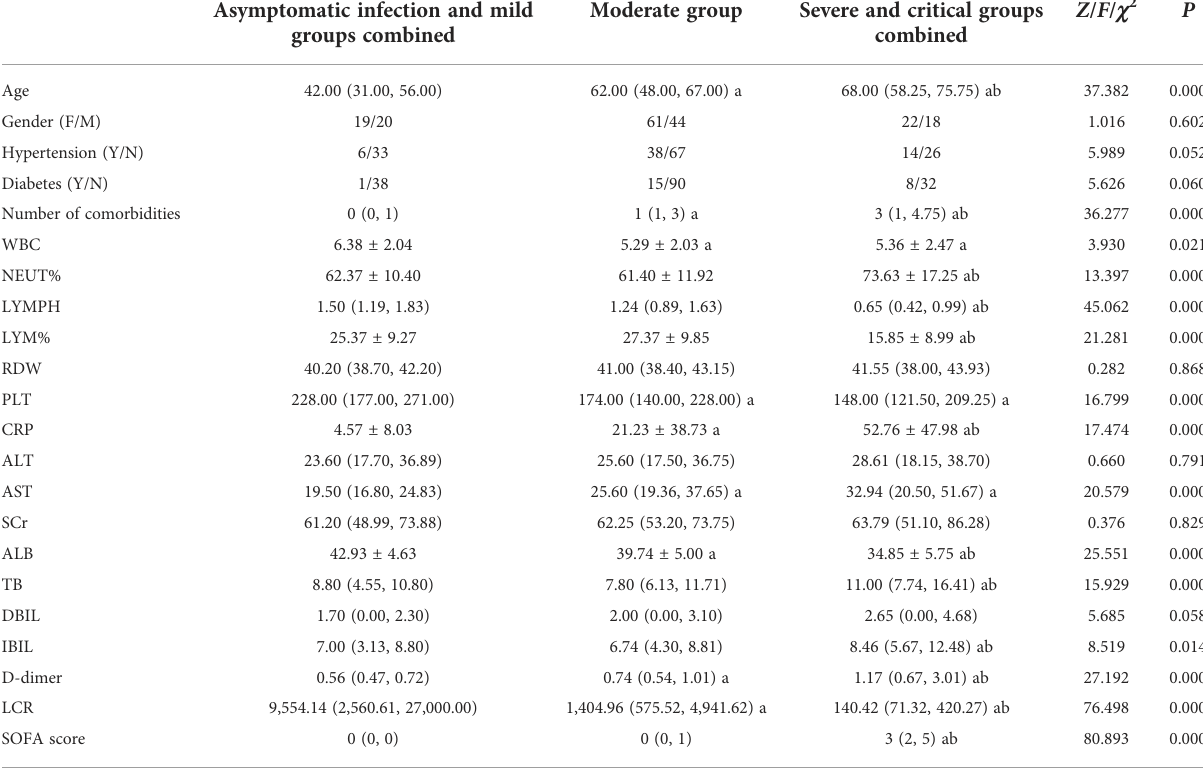
TABLE 1 Comparison of demographic and clinical baseline data among asymptomatic infection and mild groups combined, moderate group, and severe and critical groups combined. Asymptomatic infection and mild Moderate groups combined